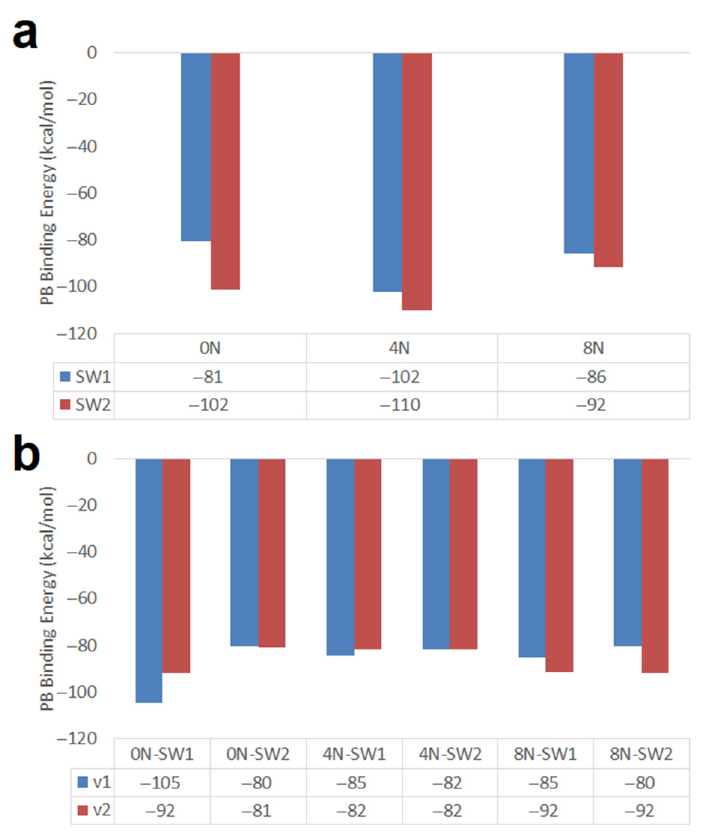
Figure 8. DOX-CNT PB binding energies for nitrogen-doped and undoped armchair (10,10) nano- tubes of different length having one and two Stone–Wales defects. ( a ) 20 Å length; ( b ) 34 Å